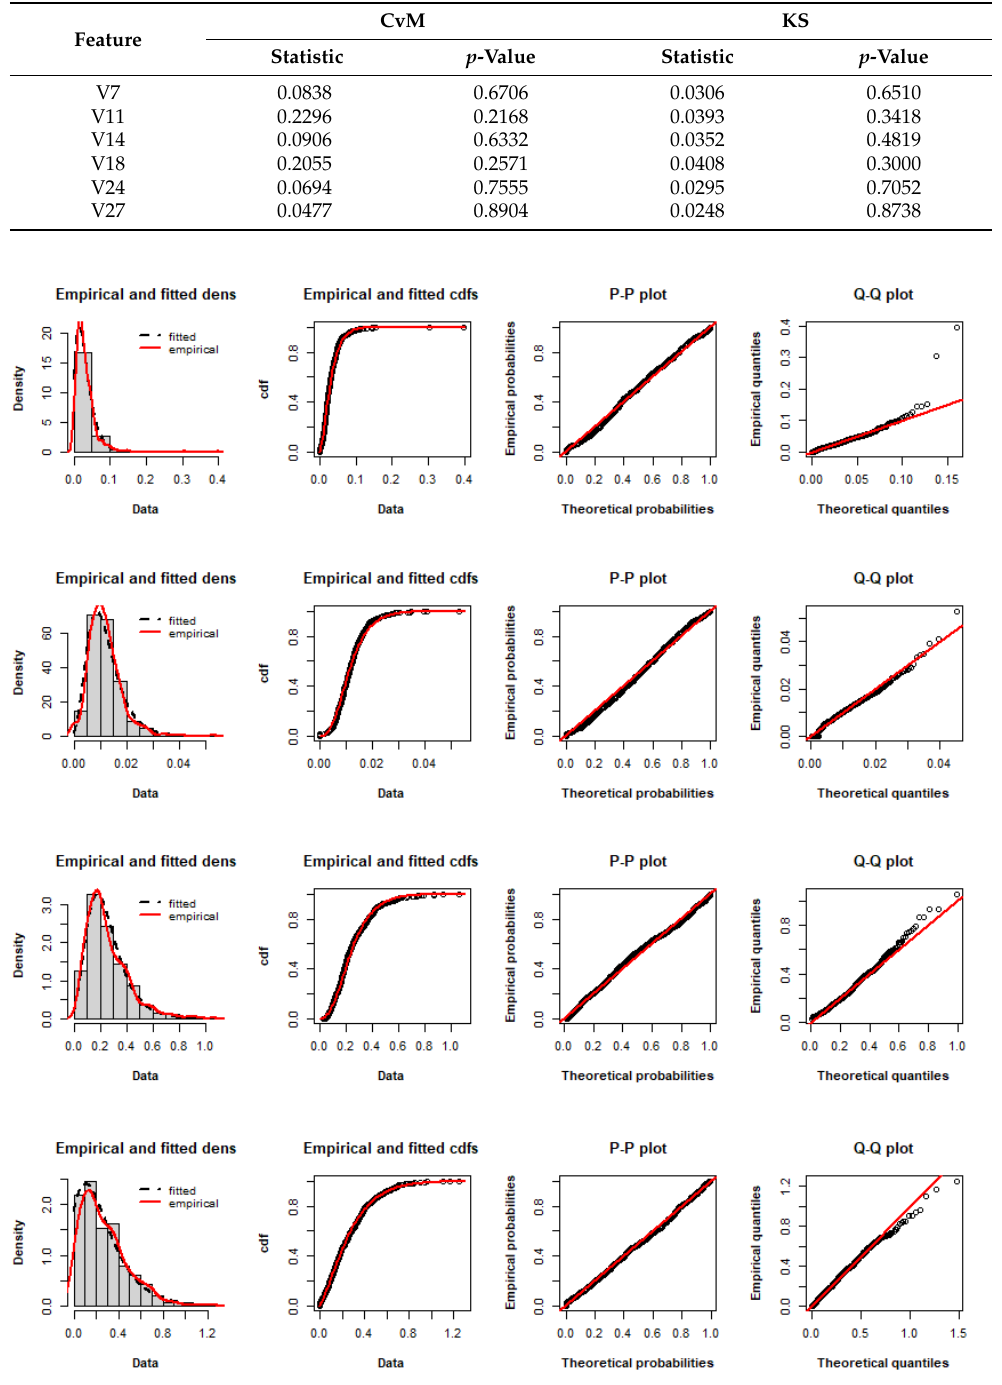
Figure 5. Empirical densities, empirical cdfs, P-P plots and Q-Q plots of the fitted MPoE distribution to the V19, V20, V28 and V29